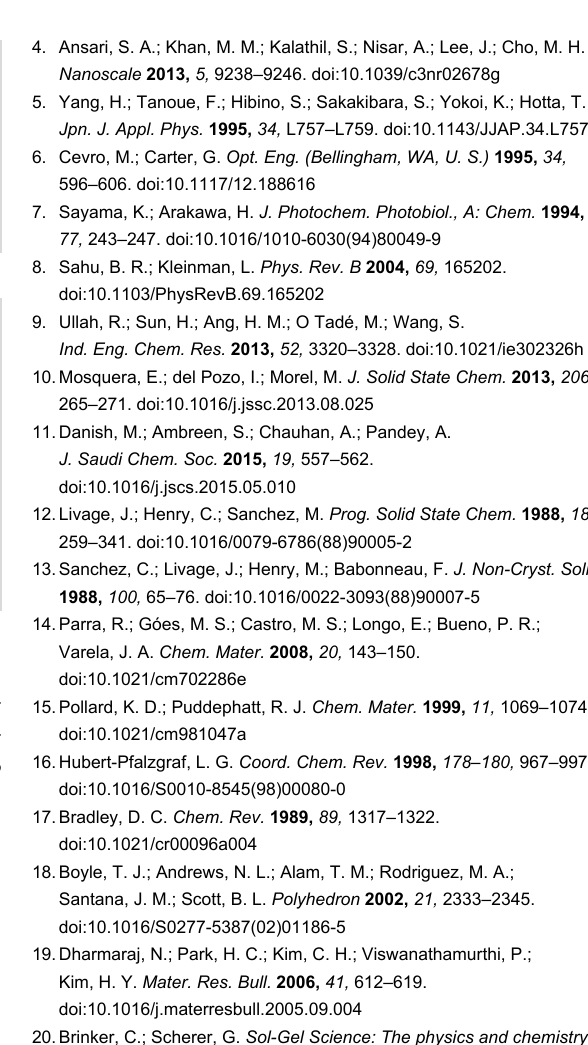
Figure 9: Graphical determination of the reaction rate of the photocatalytic degradation of RhB by Ta 2 O 5 nanoparticles derived from (a) Ta(OEt) 4 (OOCCHCl 2 ) and (b) Ta(OEt) 4 (OOCCCl 3 ).